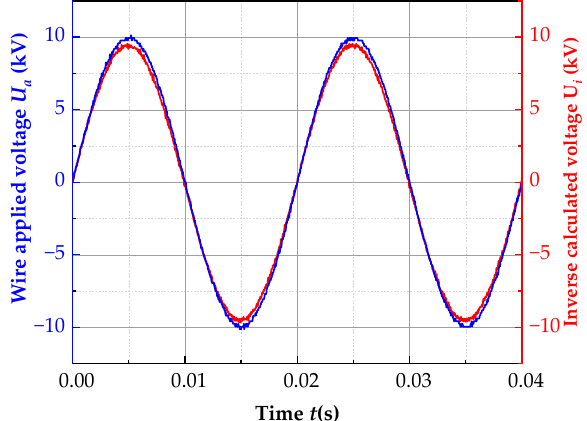
Figure 12. The inversion calculation of the line-voltage waveform and the actual voltage comparison.